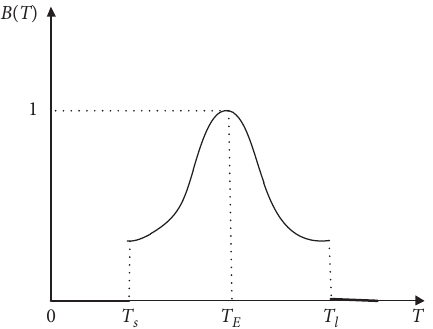
Figure 5: Fuzzy set B ’s membership function.